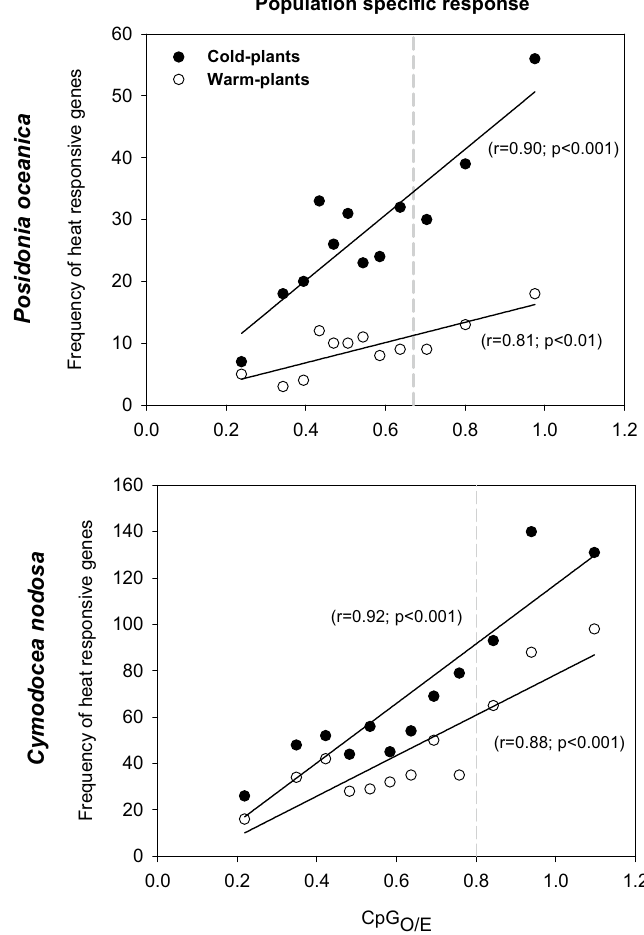
Figure 5. Relationship between CpG O/E and frequency of heat responsive genes of P. oceanica (upper panels) and C. nodosa (lower panels) cold- (solid circles) and warm-plants (empty circles). Frequency of heat flexible genes: each data point represents the number of DEGs (FDR < 0.05) responding to the thermal treatment within each of CpG O/E bins and the mean CpG O/E for the